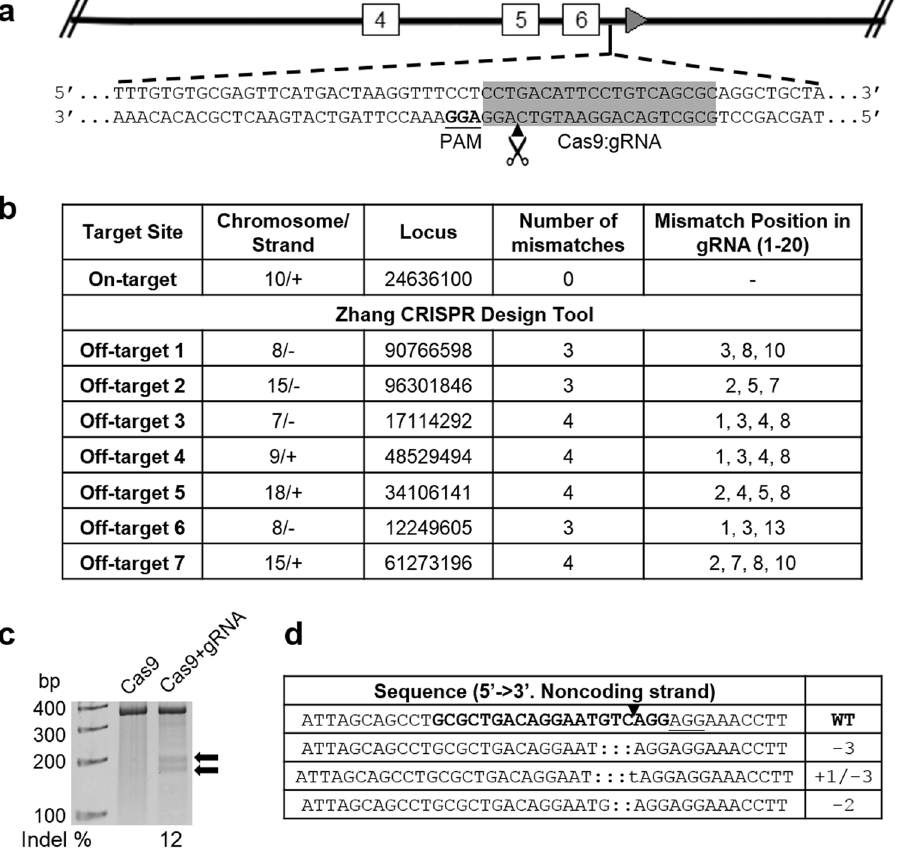
3 Scientific RepoRts | 7: 2585 | DOI:10.1038/s41598-017-02927-2